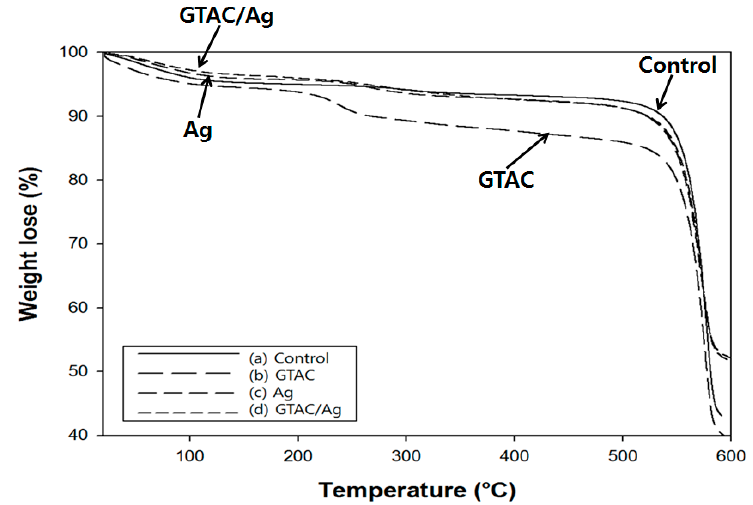
Figure 5. TGA pattern of ( a ) untreated p -aramid and ( b ) treated p -aramid with 10 wt % of GTAC; ( c ) treated p -aramid with 30,000 ppm of AgNPs; ( d ) treated p -aramid with 10 wt % of GTAC/30,000 ppm of AgNPs. of